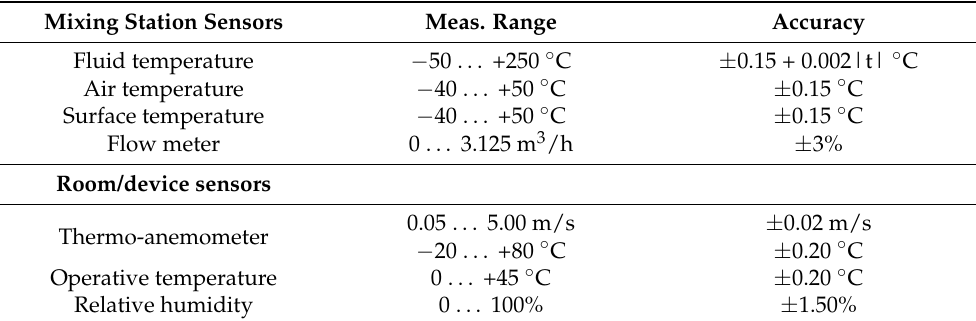
Table 1. Characteristics of the sensors employed in the experiments.